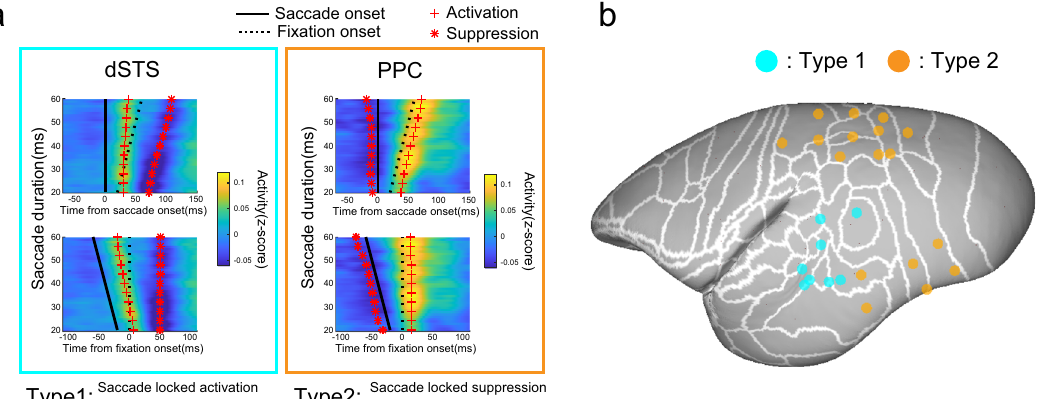
Fig. 5 Distinctive pro fi les across the dSTS and PPC on saccade- or fi xation-evoked activation and suppression. a Examples of perisaccadic high-gamma signals aligned either to saccade or fi xation onset. High-gamma signal modulation with different saccade durations was computed to test whether the signal was better explained by saccade (top row) or fi xation onset (bottom row). The solid and dotted lines show saccade and fi xation onset, respectively. The red crosses are the timing of the activation peak for each saccade duration, and the asterisks are for suppression. For the dSTS, activation timing was well explained by saccade onset, whereas suppression was according to fi xation onset (type 1), and vice versa for the PPC (type 2). b Electrode positions either classi fi ed as type 1 (cyan) or type 2 (orange). Many type 2 electrodes were in the PPC region, while type 1 electrodes clustered around the